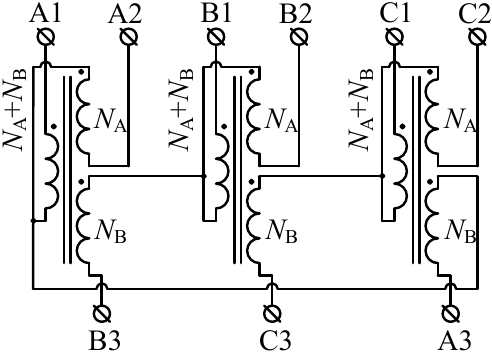
Figure 6. Four conventional matrix converters make the 12-pulse system: ( a ) schematic diagram, ( b ) the voltages discrete projection.